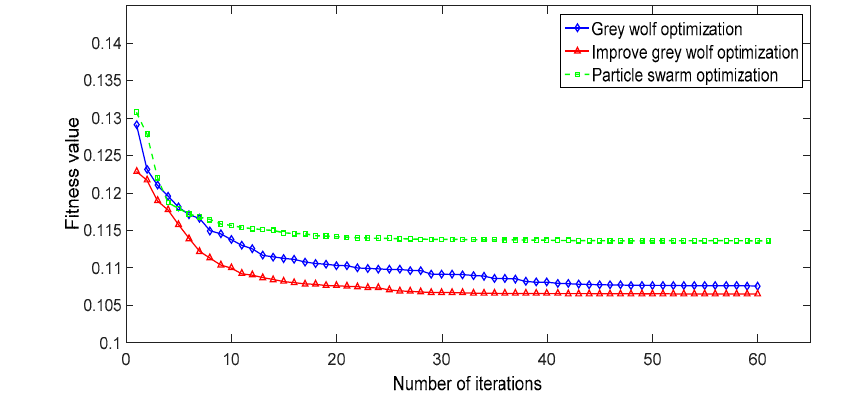
Figure 3. Comparison of fitness values. Appl. Sci. 2019 , 9 , x FOR PEER REVIEW